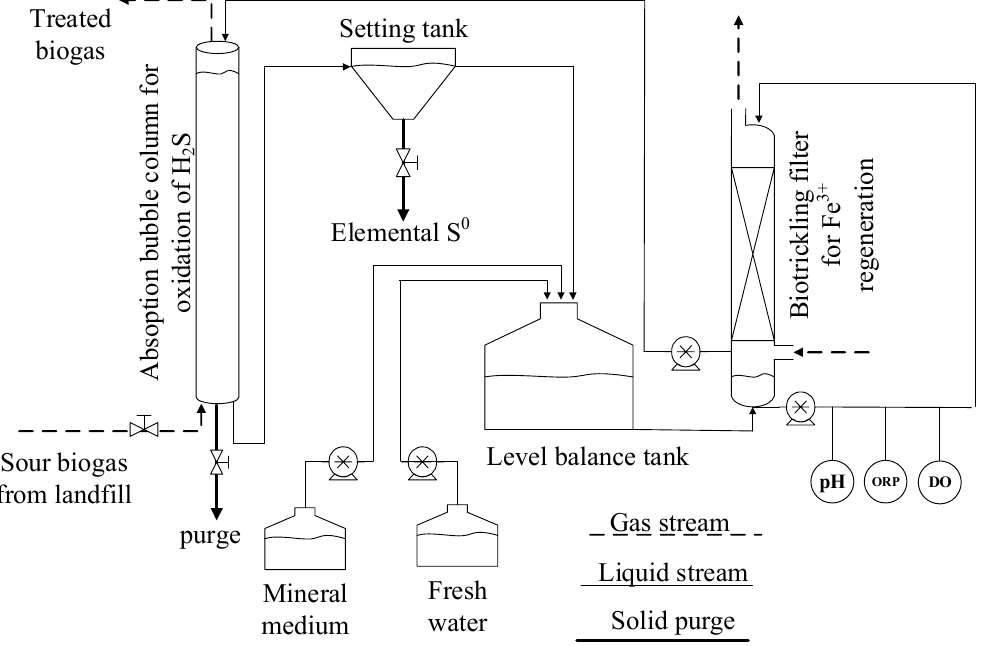
Figure 1. Desulfurization Hybrid System at Pilot Scale (HSPS) installed on a landfill